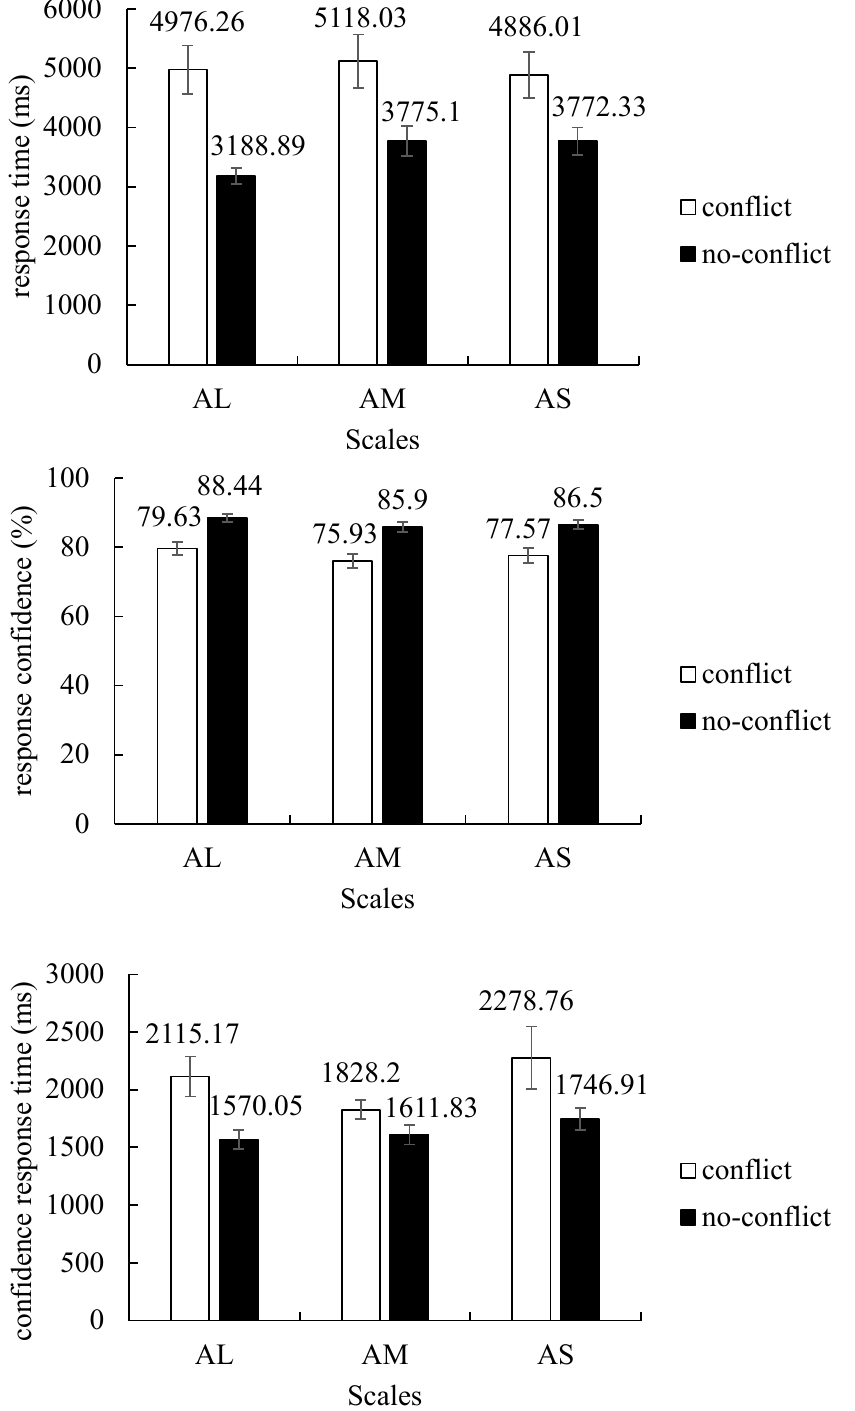
Figure 2. Response time (ms), response confidence (%), and confidence response time (ms) for “stereotypical” responses on the conflict problems and “base-rate” responses on the no-conflict problems in the AL, AM, and AS conditions. Error bars are standard errors.